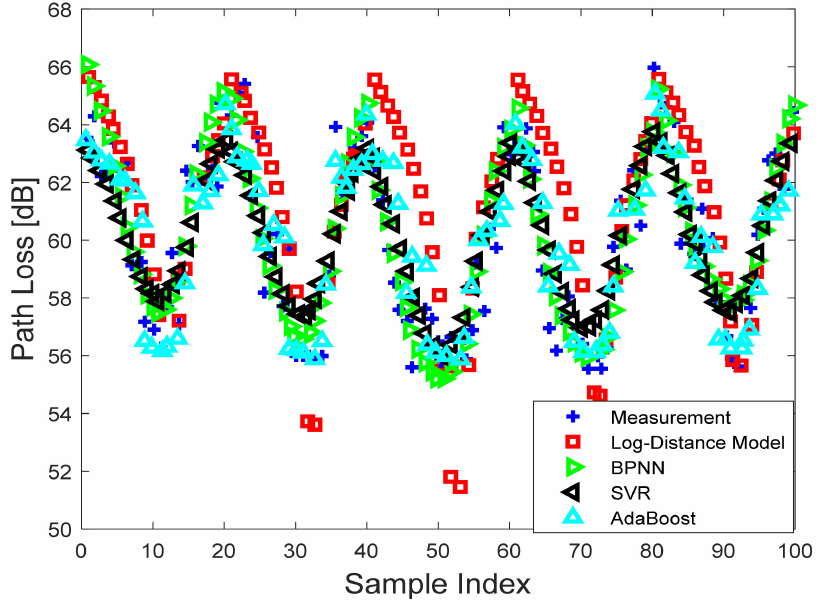
Figure 6. Path loss prediction performance of machine learning algorithms using 100 sample data for OSRC base station operating at 96.5 MHz. Note: 30 computed and 30 measured samples were used during the